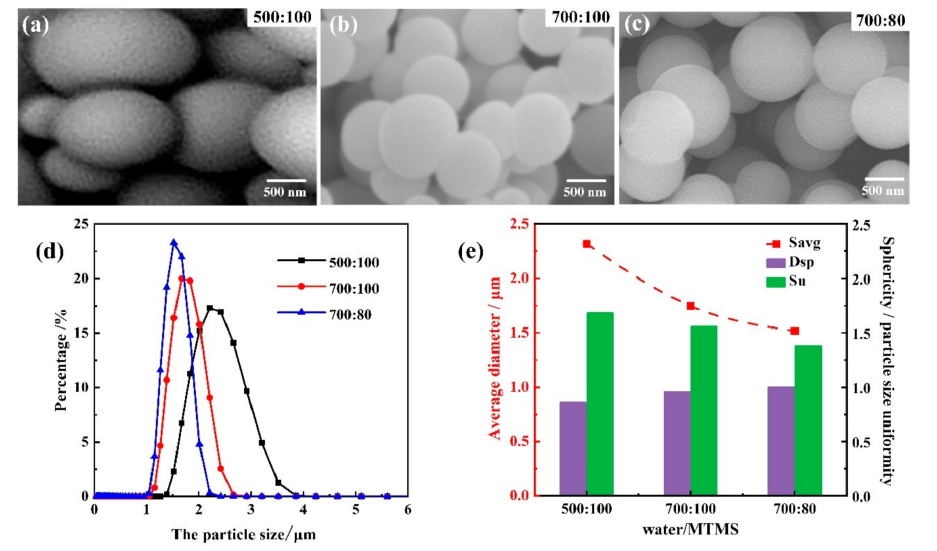
Figure 3. Morphology and particle size distribution of as-prepared PMSQ microspheres with different water/MTMS ratios. ( a ) SEM image of PMSQ microspheres with water/MTMS ratio 500:100. ( b ) SEM im- age of PMSQ microspheres with water/MTMS ratio 700:100. ( c ) SEM image of PMSQ microspheres with water/MTMS ratio 700:80. ( d ) Particle size distribution of PMSQ microspheres, and ( e ) average diameter, sphericity, and particle size uniformity of PMSQ microspheres with different water/MTMS